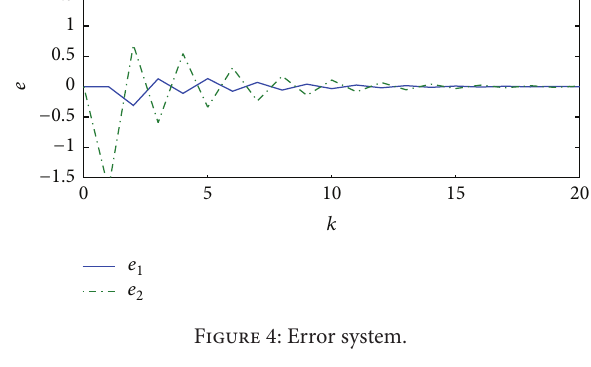
Figure 4: Error system.